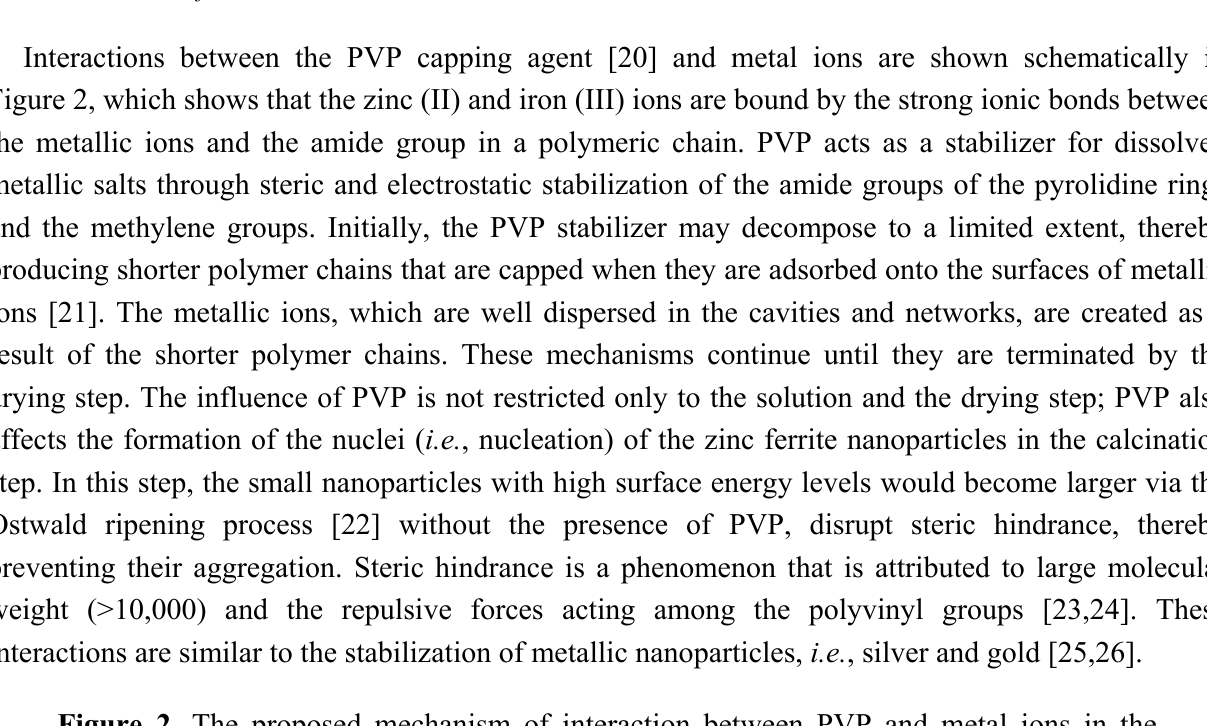
Figure 2. The proposed mechanism of interaction between PVP and metal ions in the formation of the zinc ferrites